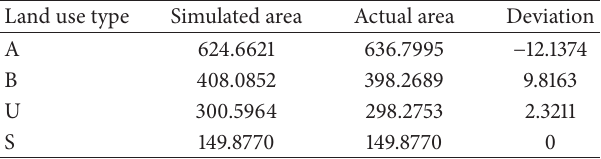
Table 5: Comparison of simulated area and actual area (area unit: km 2